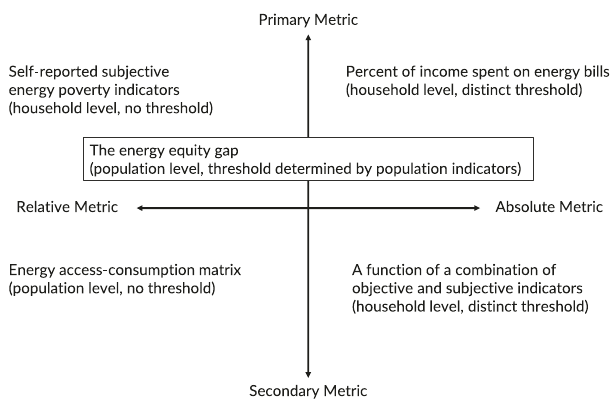
Fig. 1 Categories of energy poverty metrics. The X -axis represents relative or absolute metrics, or whether the metric has a distinct threshold for energy poverty. The Y -axis represents primary or secondary metrics, or whether a metric requires more than basic consumer-level data to calculate. A primary-absolute metric can be energy burden, or percent of income spent on energy bills; a primary-relative metric can be self-reported energy poverty indicators; a secondary-absolute metric can be a combination of the previous two, where an arbitrary score is calculated based on energy burden and survey results; and a secondary-relative metric can be an energy access-consumption matrix, often used to portray the progress of energy access in developing countries. The energy equity gap is a primary metric that can be both relative and absolute, where it can tell us the relative energy equity progress of a region, as well as household-level energy